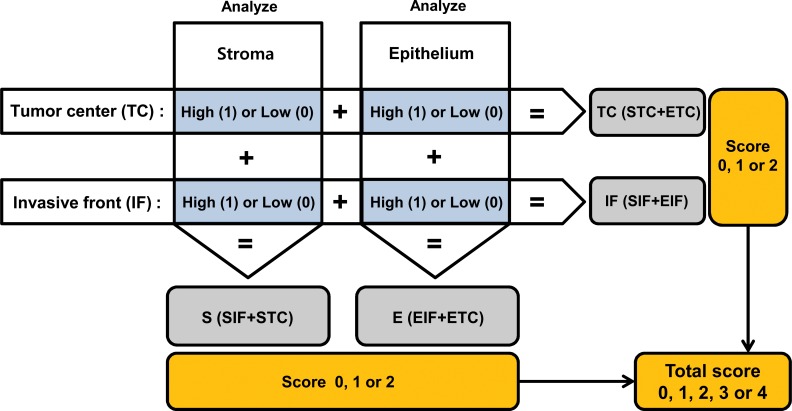
Development of the scoring system.The total score was determined by adding the scores of four different areas (S and E compartments of IF and TC regions). In addition to the total score, analysis of the compartments (S or E) and regions (IF or TC) was conducted by adding the scores of two paired areas, e.g., to determine the score of IF. We added the scores in S at IF and E at IF, which ranged from 0 to 2. For the S compartments, the scores in S at IF and S at TC were added. The same method was applied in scoring of the densities of TAMs of the other two combined areas–TC (STC + ETC) and E (EIF + ETC). Abbreviations: S, stroma; E, eithelium; IF, invasive front; TC, tumor center.